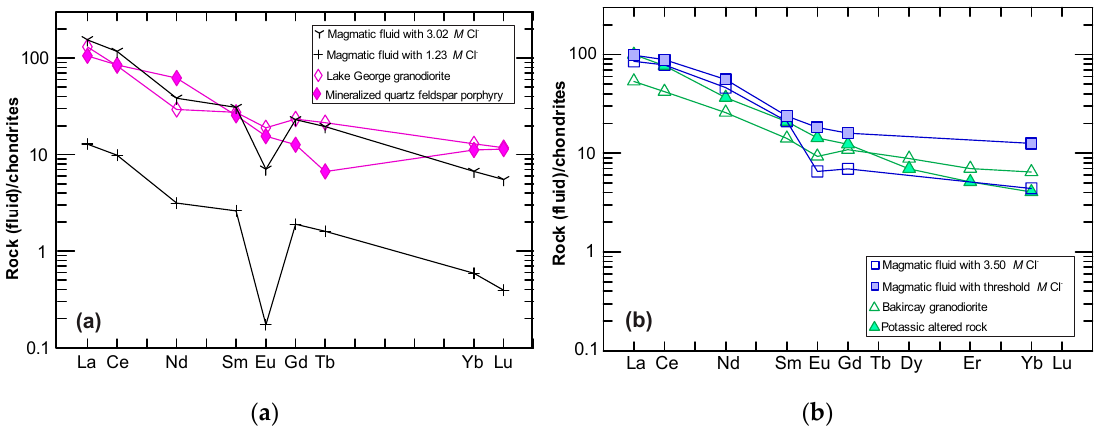
Figure 5. ( a ) A comparison of chondrite-normalized REE patterns of calculated magmatic fluids, the Lake George granodiorite and mineralized quartz-feldspar porphyry; ( b ) chondrite-normalized REE patterns of the Bakircay granodiorite, potassic altered rock, and the calculated magmatic fluids. The chondrite normalizing values are from [38].